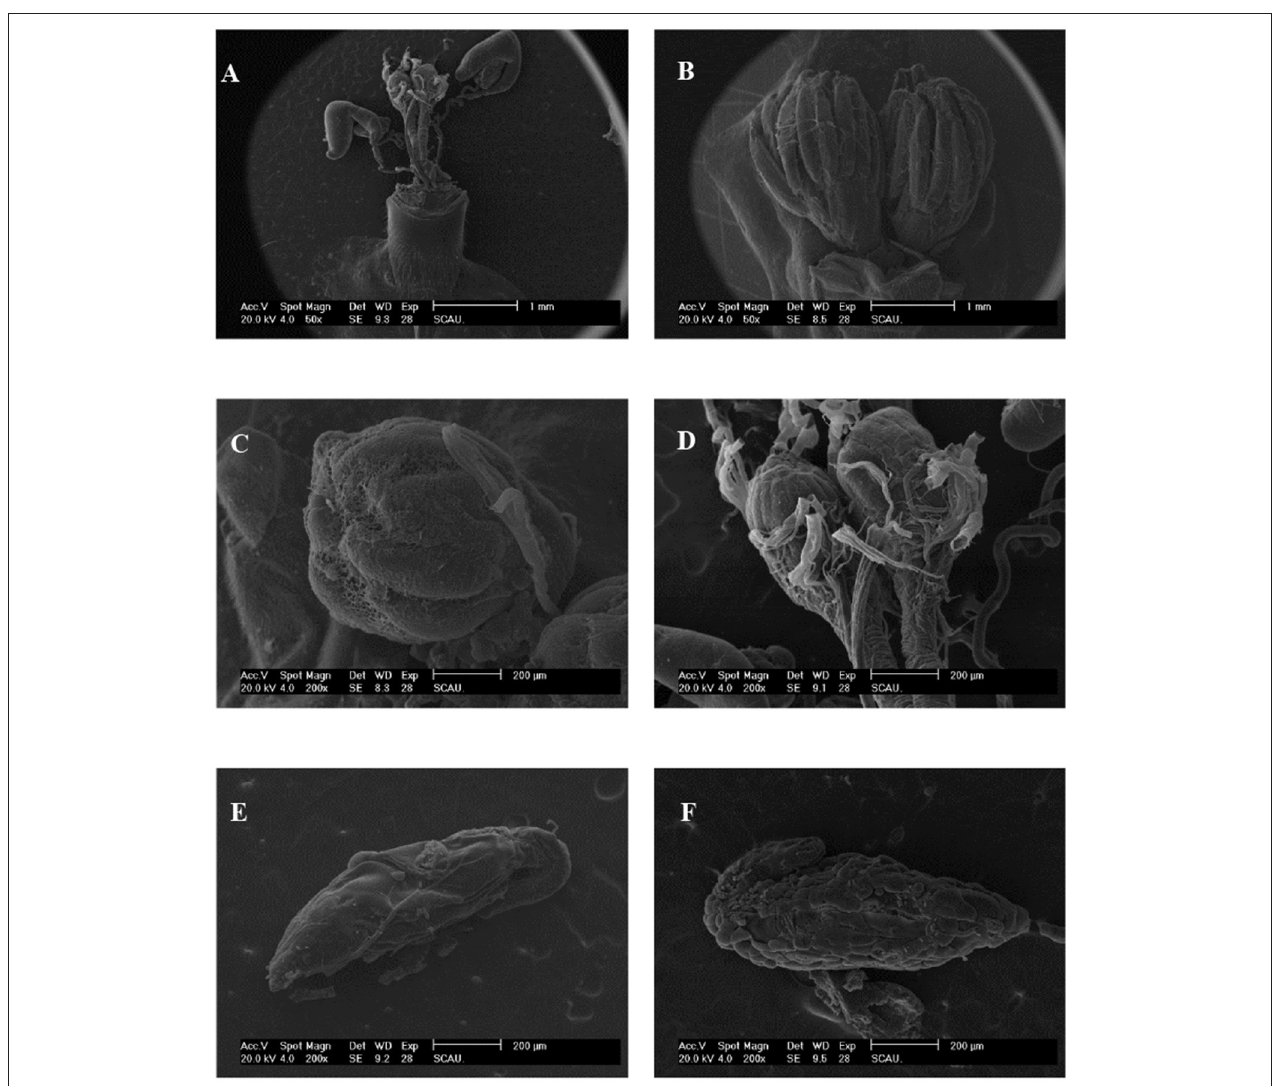
FIGURE 3 | SEM of morphological characteristics of reproductive organs in control and irradiated B. tau . (A) Complete and (B) Intact construction of ovaries of B. tau ( × 50). (C) Ovary of an untreated female ( × 200). (D) Ovary of an irradiated female ( × 200). (E) Testis of an untreated male ( × 200). (F) Testis of an irradiated male ( × 200).